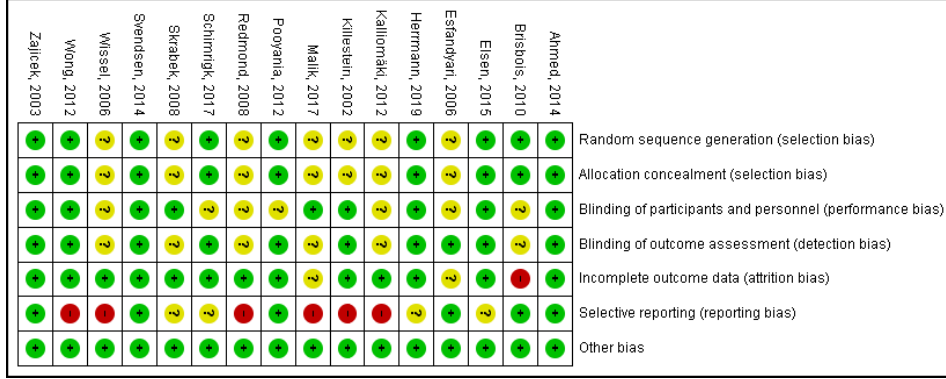
Figure 2. Table of biases.